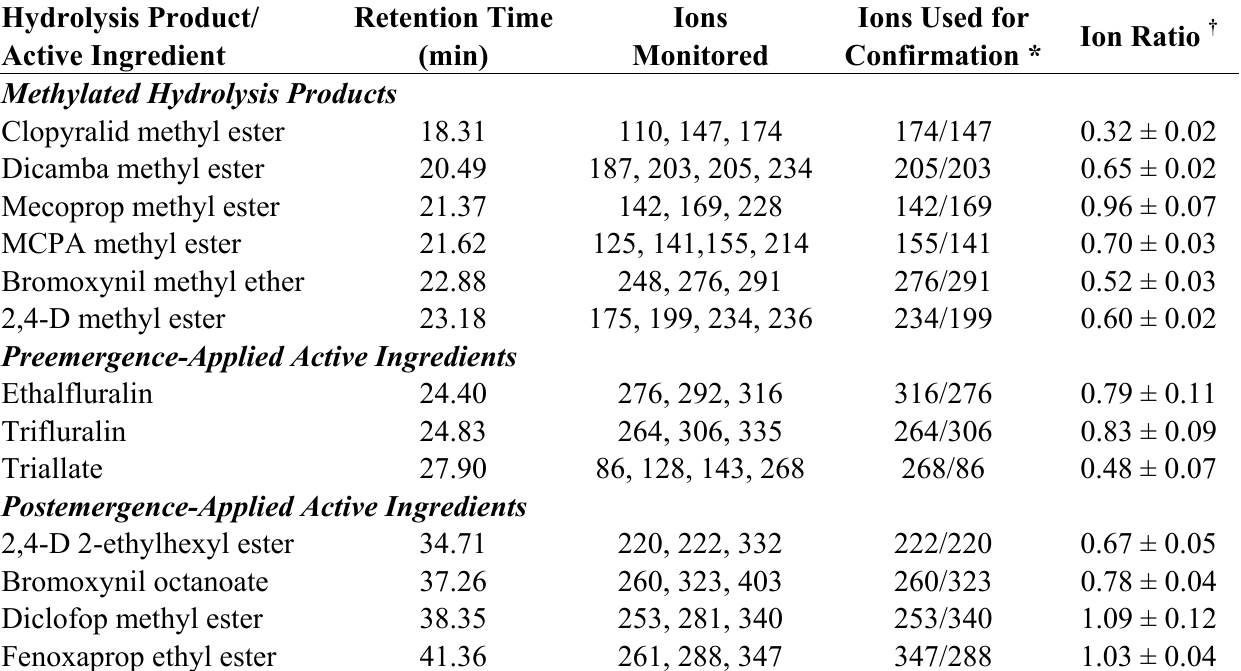
Table 2. The methylated hydrolysis products and the preemergence-applied and postemergence-applied active ingredients in order of increasing retention time, the ions monitored, and the relative response of ions used for confirmation